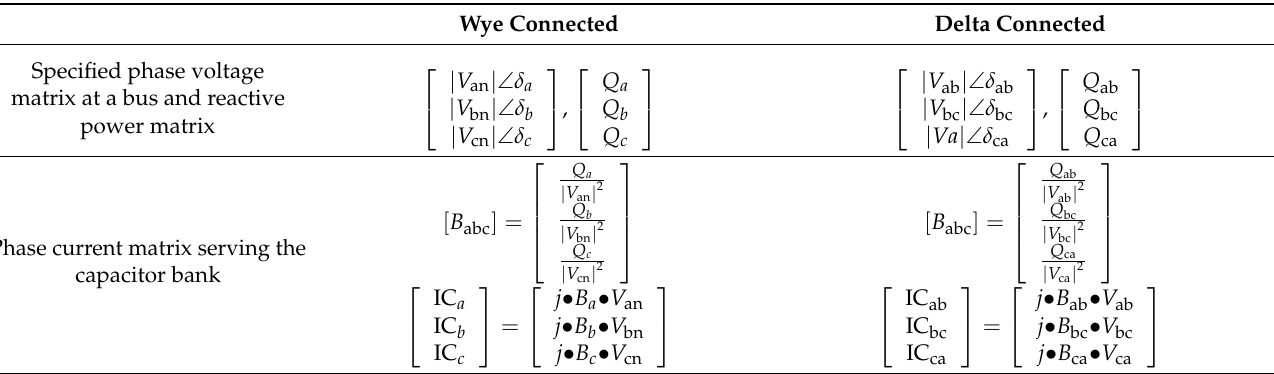
Table 1. Modeling of capacitor